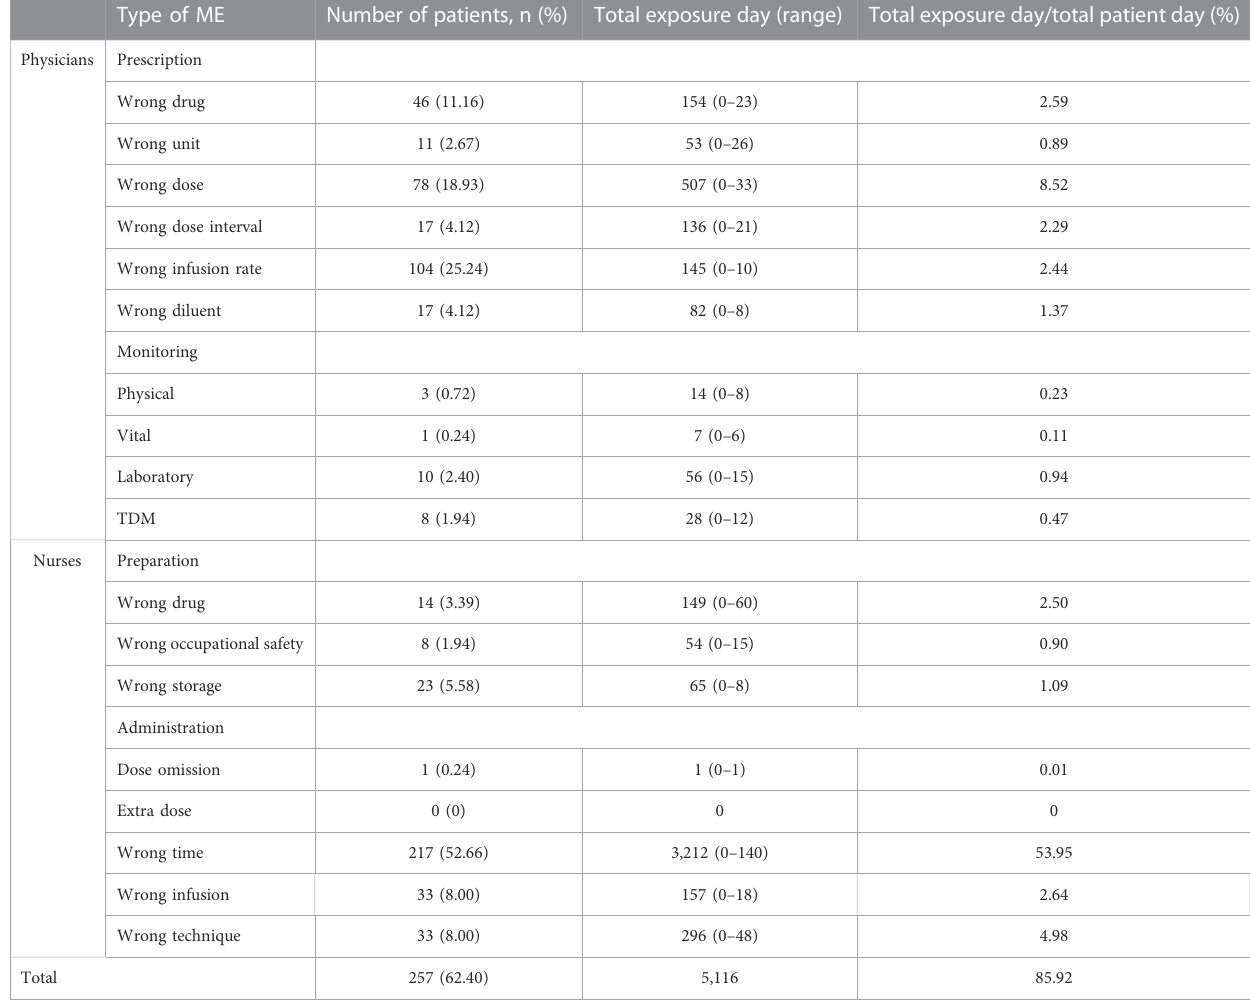
TABLE 2 Distribution of the number of patients, duration of exposure, and total patient days for each medication